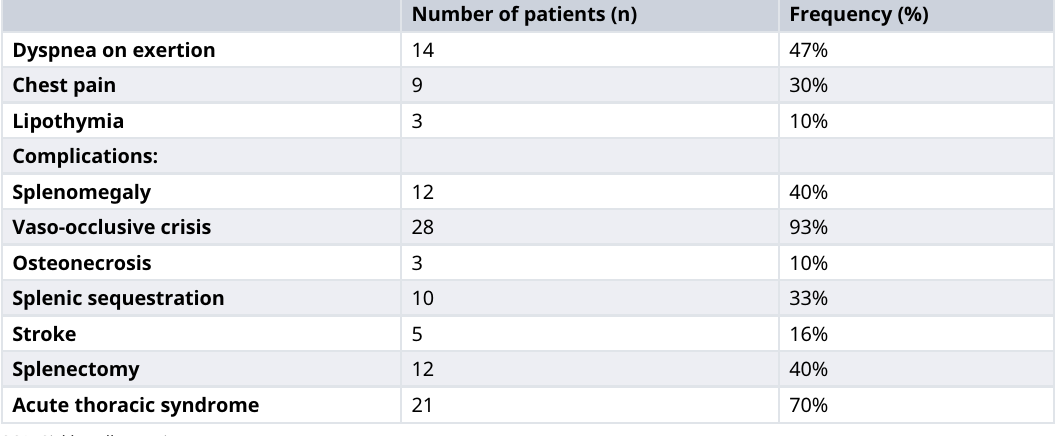
Table 2. Clinical findings and complications in the SCA group (N=30).